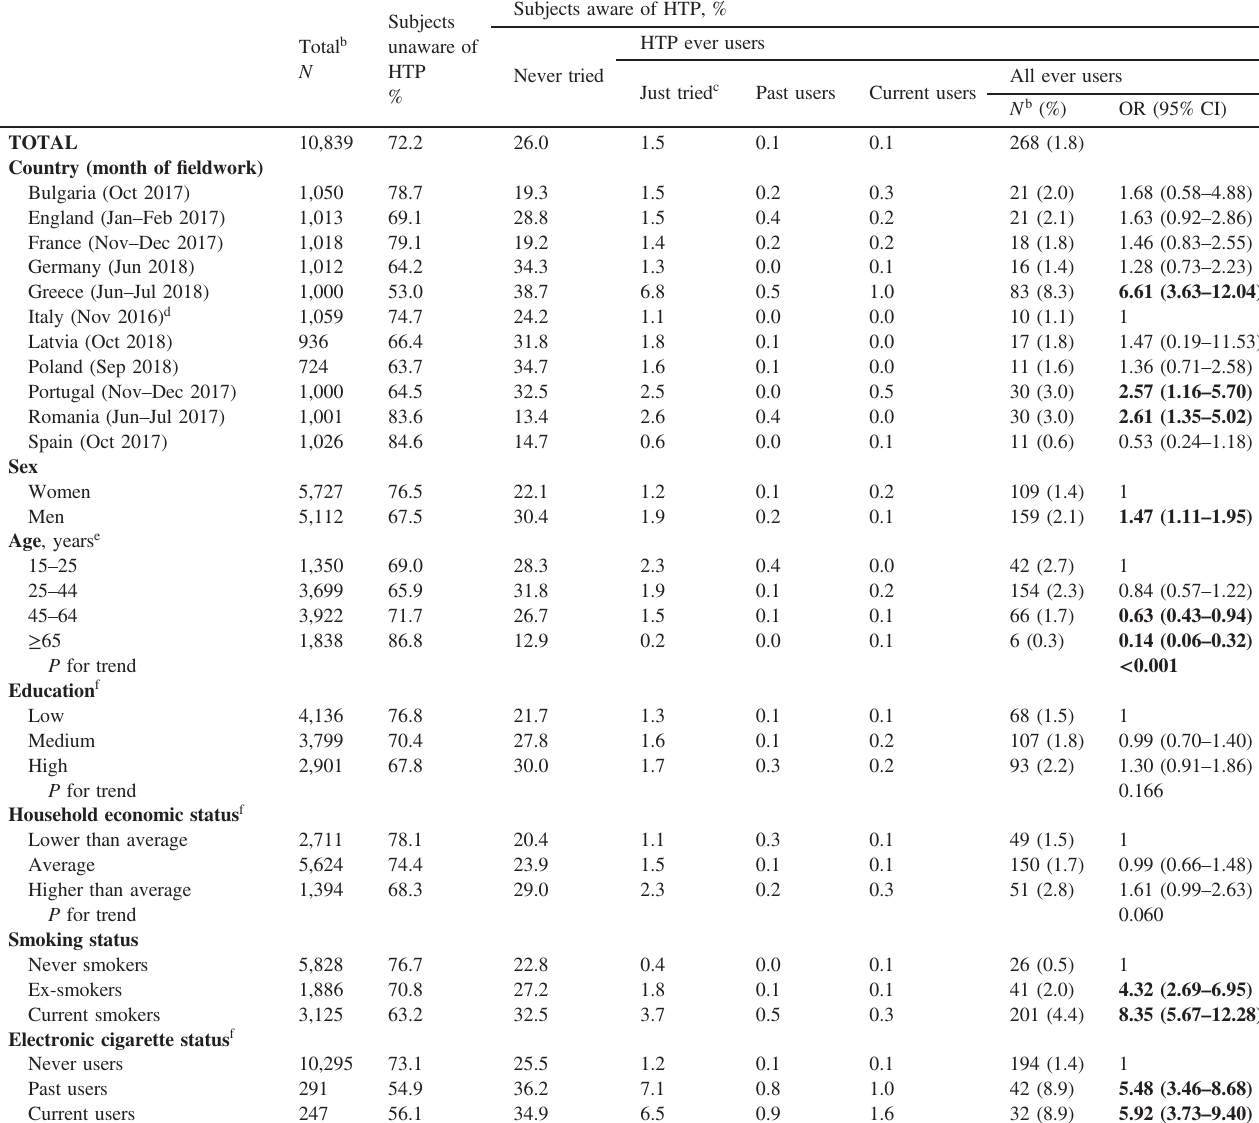
Table 1. Odds ratios a (OR) for heated tobacco product (HTP) ever vs never use and corresponding 95% con fi dence intervals (CI) in the European population aged ; 15 years, according to selected individual-level characteristics. TackSHS, 2017 –